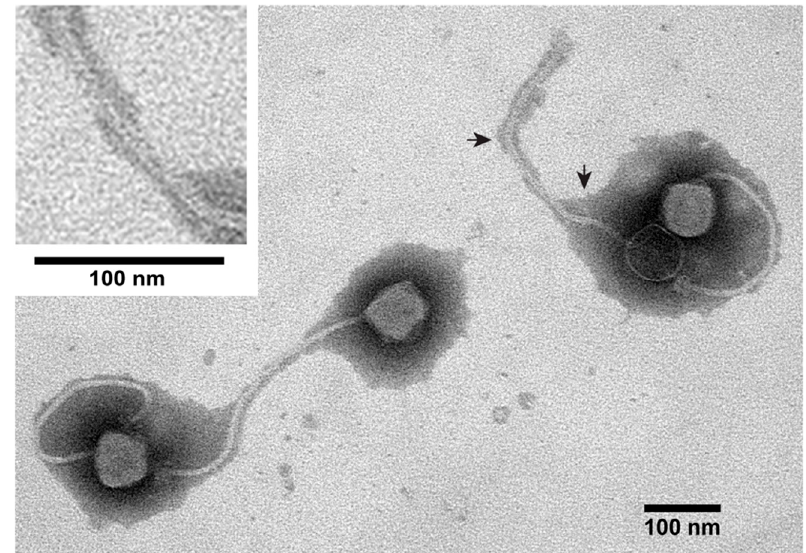
Figure 2. Electron microscopy of Bacillus pumilis siphophage 0104phi1-1. The sample was prepared by negative staining with 1.0% uranyl acetate [2]. The inset has a higher magnification image of the section of a tail indicated by the two arrows.